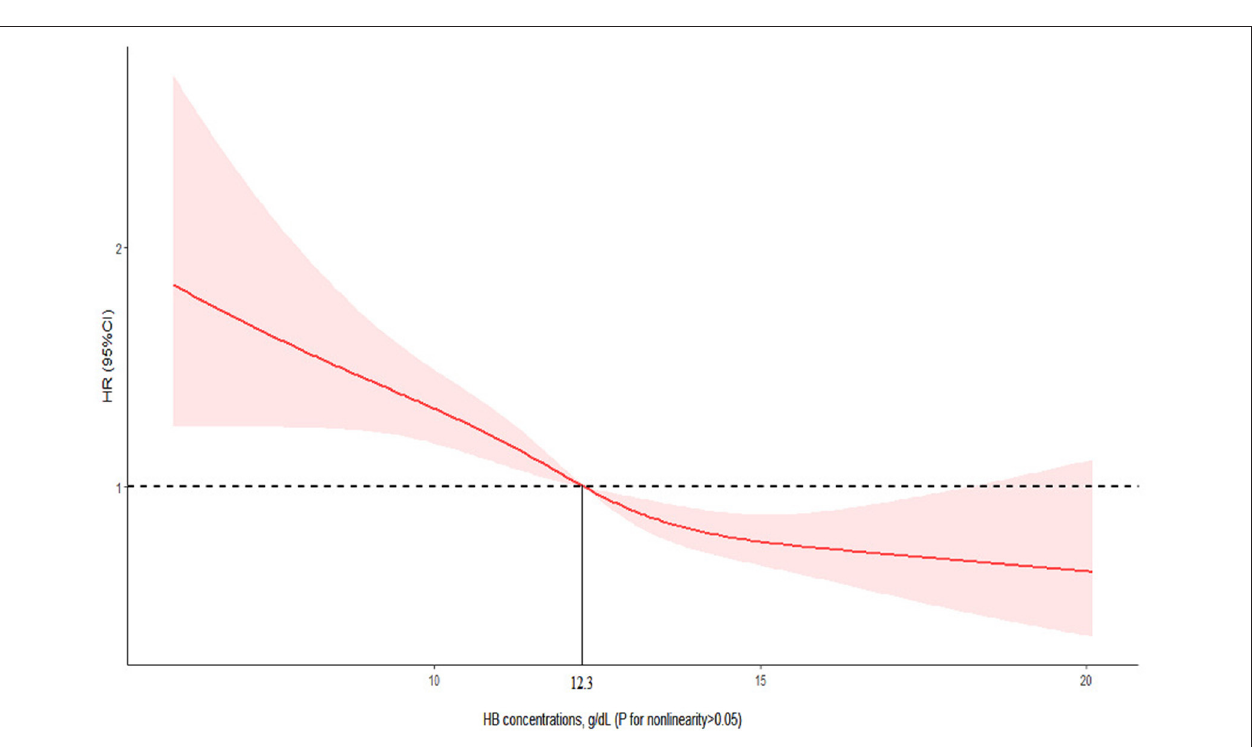
linear association was also observed between HB concentrations and all-cause mortality for both men and women ( Figure 3 ). For men, the risk of all-cause mortality was significantly lower with the highest HB concentration of ≥ 14.0 g/dL in the fully adjusted model (HR: 0.69, 95% CI: 0.50–0.96); and for women, the